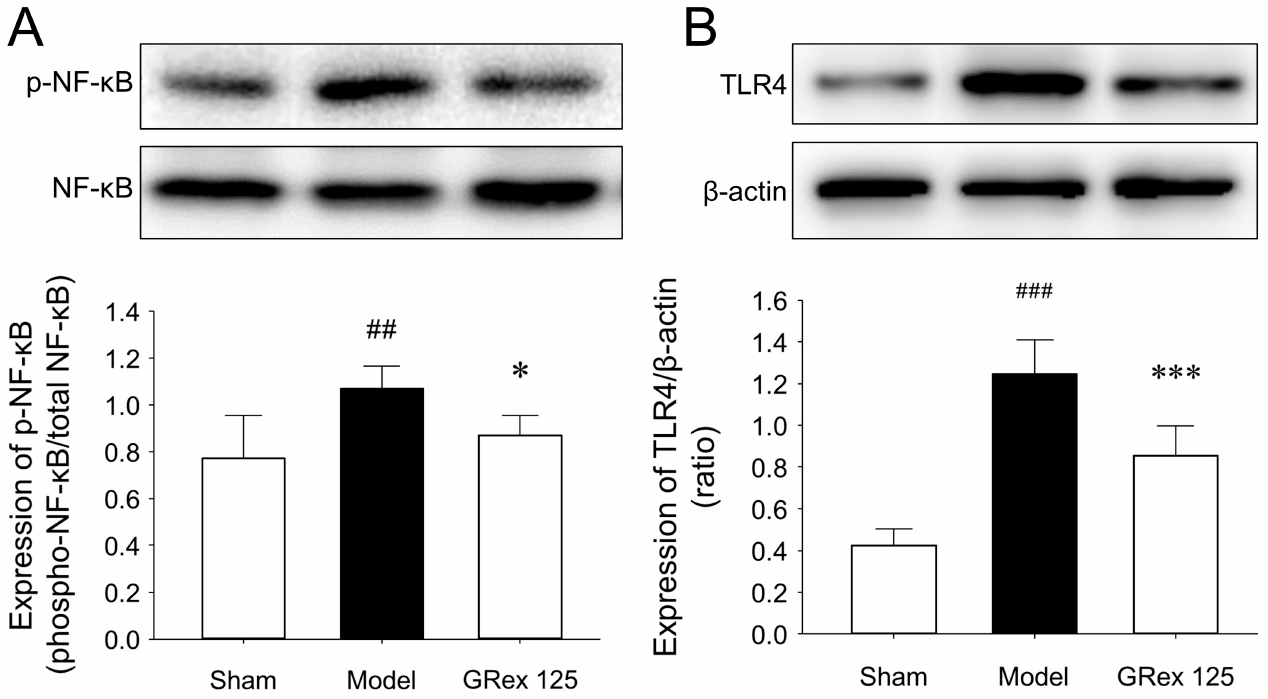
Figure 6. Effects of GRex post-treatment on the changes in NF- κ B and TLR4 proteins in MCAO- induced mouse brain. Representative images (upper column of ( A , B )) and relative densitometry (lower column of ( A , B )) of Western blot analysis of expression levels in brain tissues ( n = 5, per group). All data are expressed as mean ± SD ( n = 5). ## p < 0.01 and ### p < 0.001 compared to sham group and * p < 0.05 and *** p < 0.001 compared to MCAO model group.